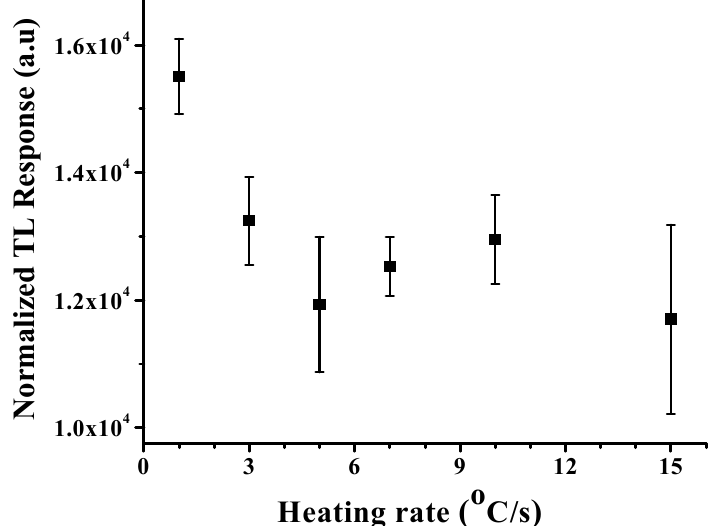
Figure 5. Heating rate dependence of thermoluminescence (TL) from MgB 4 O 7 :Zn glass.